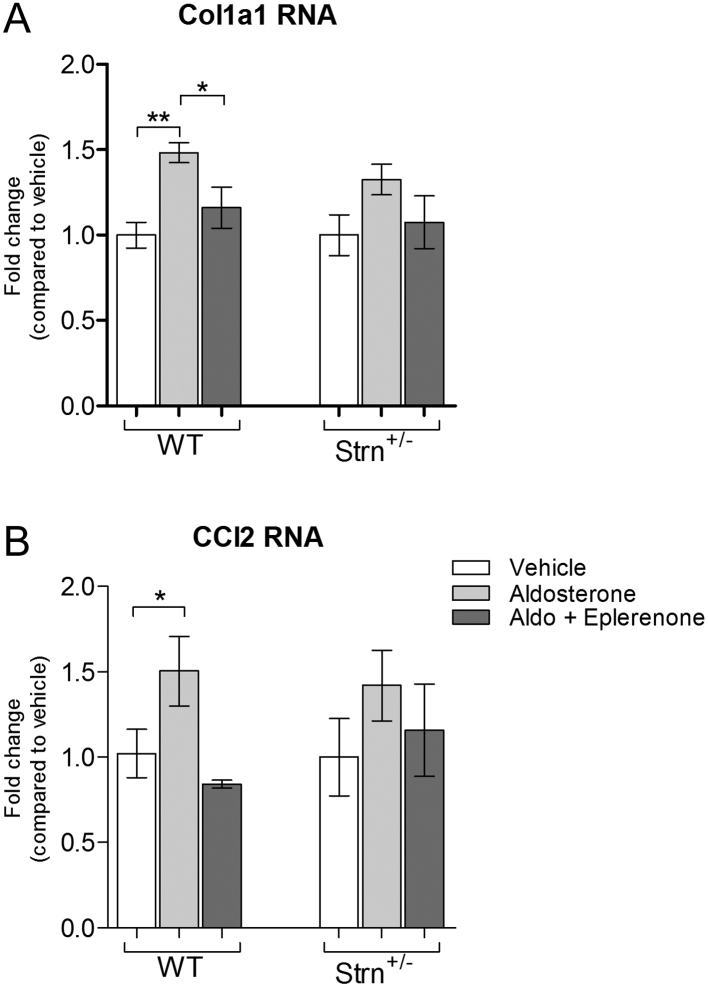
Aldosterone-induced biomarkers of damage. (A) Collagen type I alpha 1 (Col1a1), (B) C-C motif chemokine ligand 2 (CCL2). As measured by Nanostring Technologies. n = 5–6. Data presented at mean ± s.e.m. ns = P > 0.05, * = P < 0.05, ** = P < 0.01, ***P < 0.001.